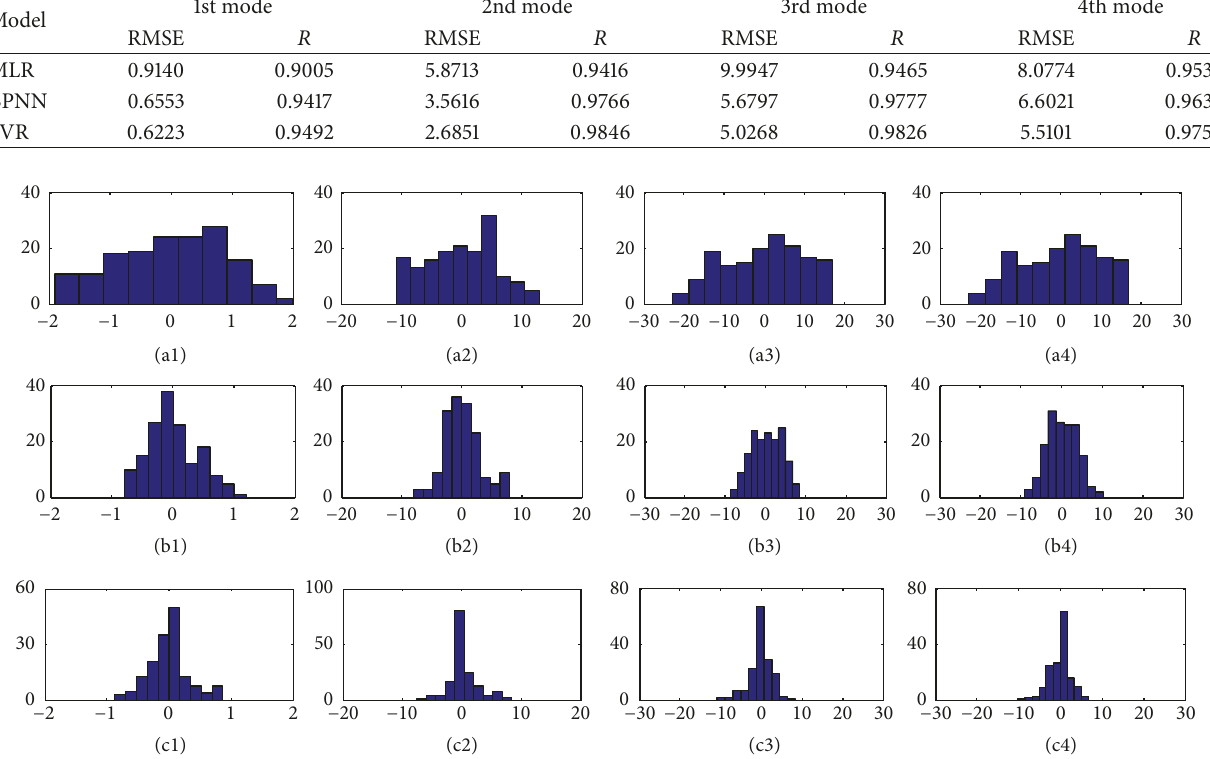
Figure 8: Histograms of PEs generated by three regression models on training set (horizontal axis represents PEs, and vertical axis represents sample number). (a1) MLR for 1st mode; (a2) MLR for 2nd mode; (a3) MLR for 3rd mode; (a4) MLR for 4th mode; (b1) BPNN for 1st mode; (b2) BPNN for 2nd mode; (b3) BPNN for 3rd mode; (b4) BPNN for 4th mode; (c1) SVR for 1st mode; (c2) SVR for 2nd mode; (c3) SVR for 3rd mode; (c4) SVR for 4th